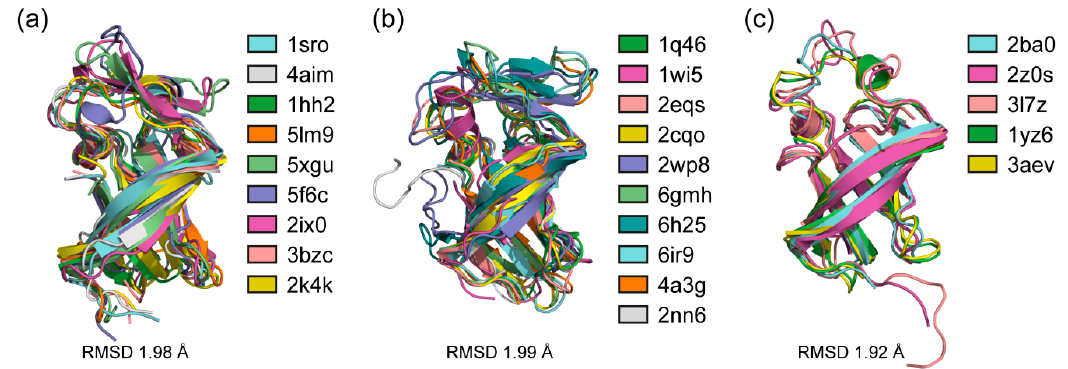
Figure 3. Structural alignments of S1 domains from ( a ) bacterial (nine structures); ( b ) eukaryotic (ten structures); ( c ) archaeal (five structures) proteins were made using the POSA interactive server to align multiple protein structures [39]. The average root-mean-square deviation (RMSD) for the bacterial S1 domains is 1.98 Å, for eukaryotics is 1.99 Å, for archaeal proteins is 1.92 Å.